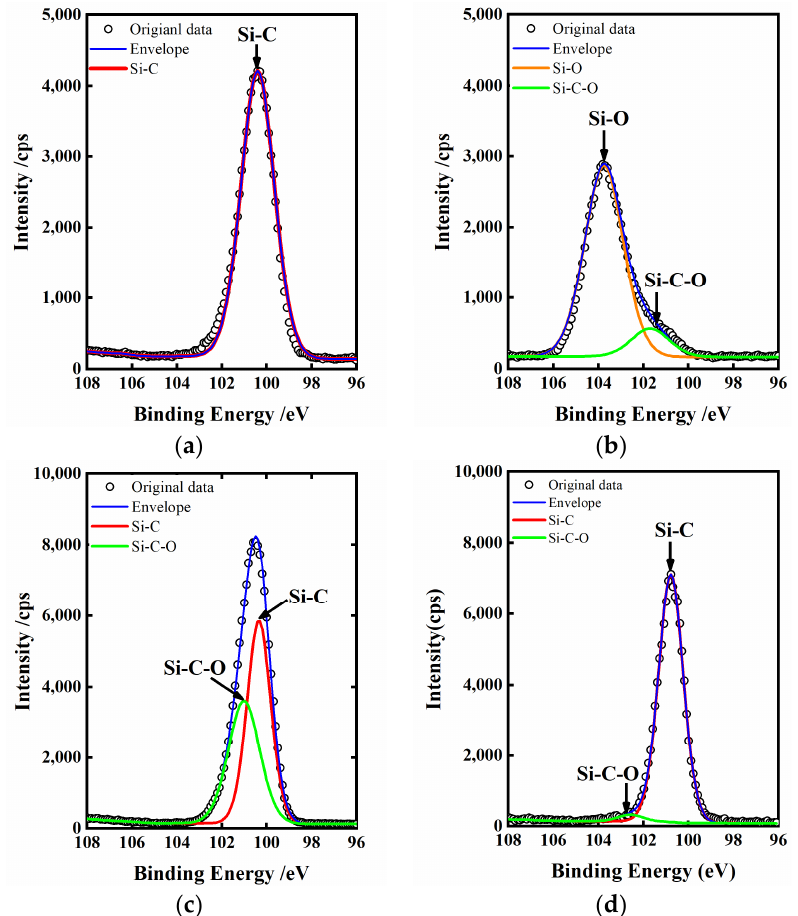
Figure 6. X-ray photoelectron spectroscopy (XPS) analysis of single-crystal 4H-SiC surface: ( a ) Chemical cleaned surface; ( b ) After plasma electrolytic processing for 30 s; ( c ) After HF etching for 10 min; ( d ) After mechanical polishing for 5 min.